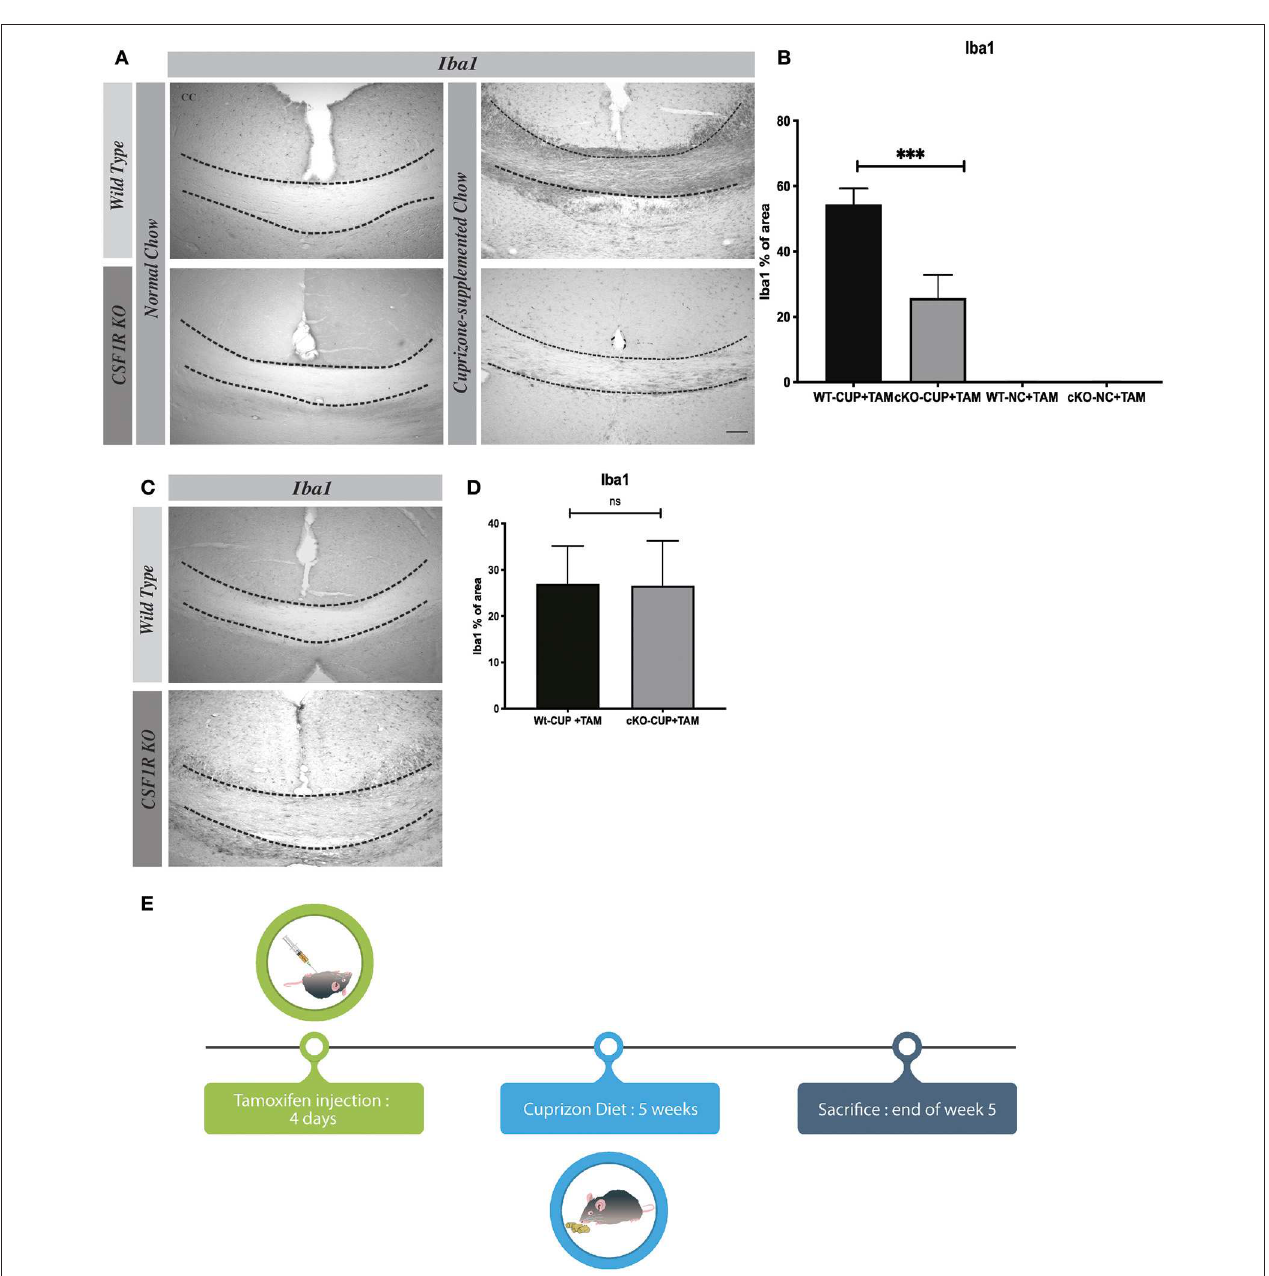
FIGURE 5 | In Cuprizone Diet model CSF1R depleted-microglia affect their proliferation. (A) Representative images of Iba1 staining in corpus callosum and (B) their quantification presented as percentage of area occupied by the staining, measured in the corpus callosum. Cuprizone supplemented chow (CUP) or Normal Chow (NC). (C) Representative images of Iba1 staining in corpus callosum and (D) their quantification presented as percentage of area occupied by the staining, measured in the corpus callosum, 5 days after cuprizone withdraw. (E) Timeline cuprizone protocol. Value are expressed as means ± SEM. Statistical analyses were performed using t -test *** p < 0.001 significantly different from group cKO-CUP + TAM. N = 3–6 mice. Scale bar: (A) 100 µ